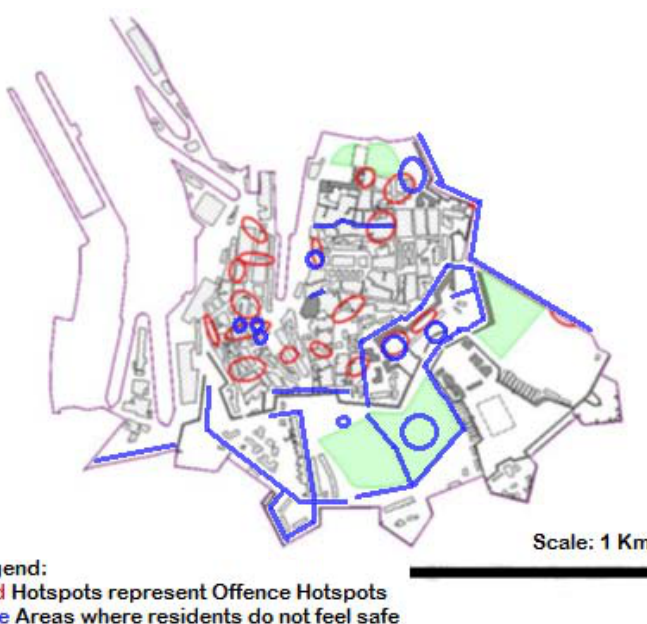
Figure 7. Areas where residents do not feel